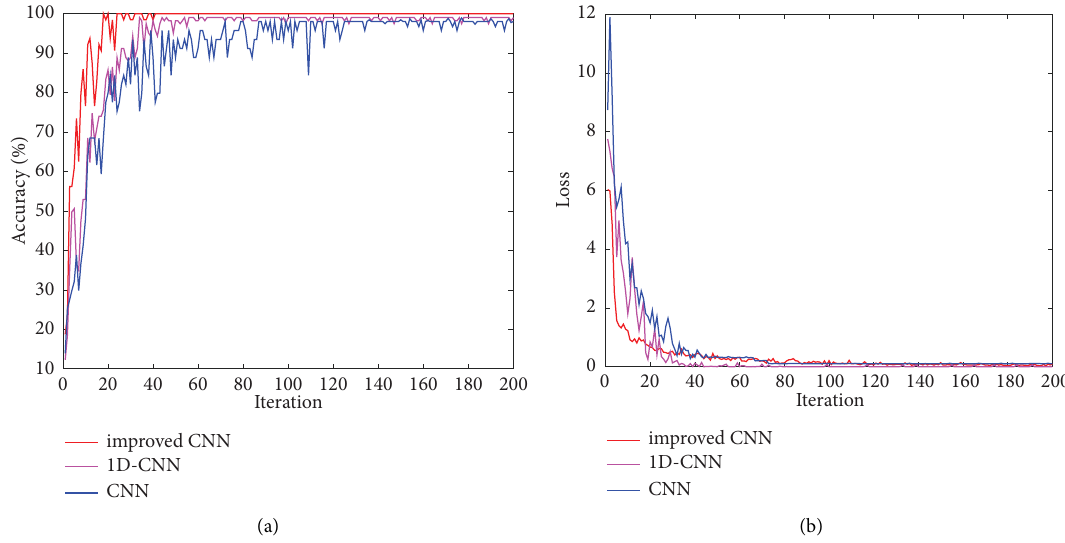
Figure 14: Curves of training result. (a) Te curve of accuracy and (b) the curve of loss.